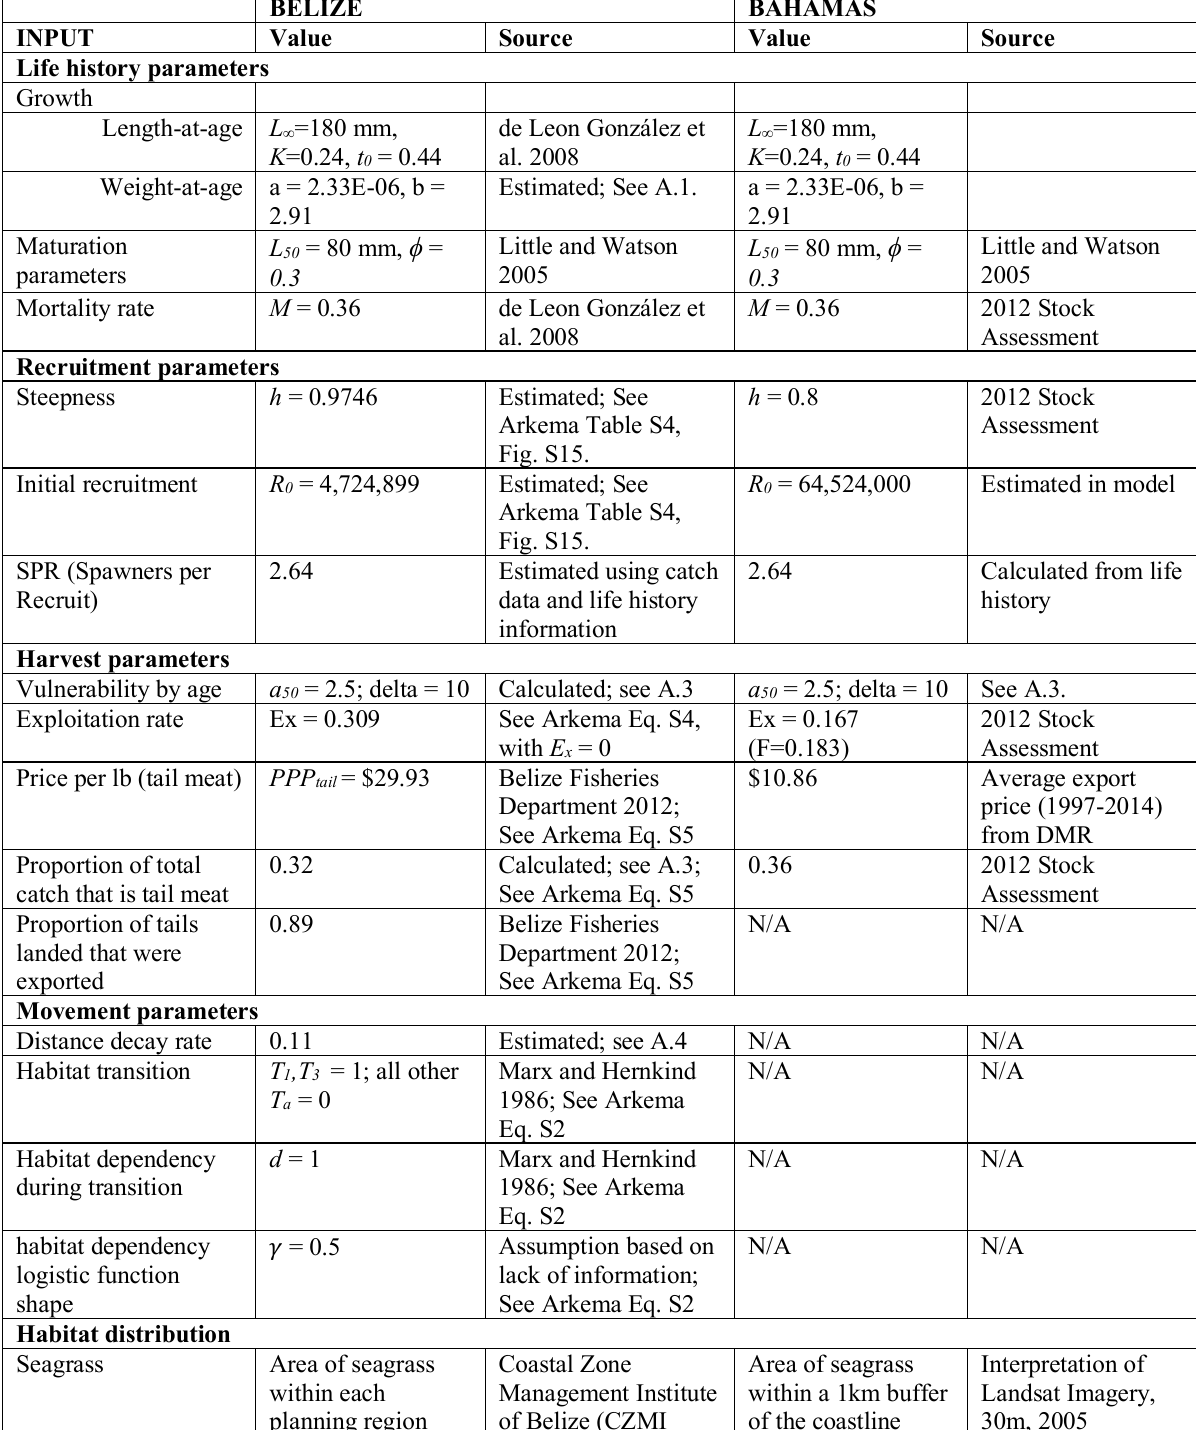
Table A1.2 Key inputs to Fisheries Production models for spiny lobster (Belize and Bahamas)